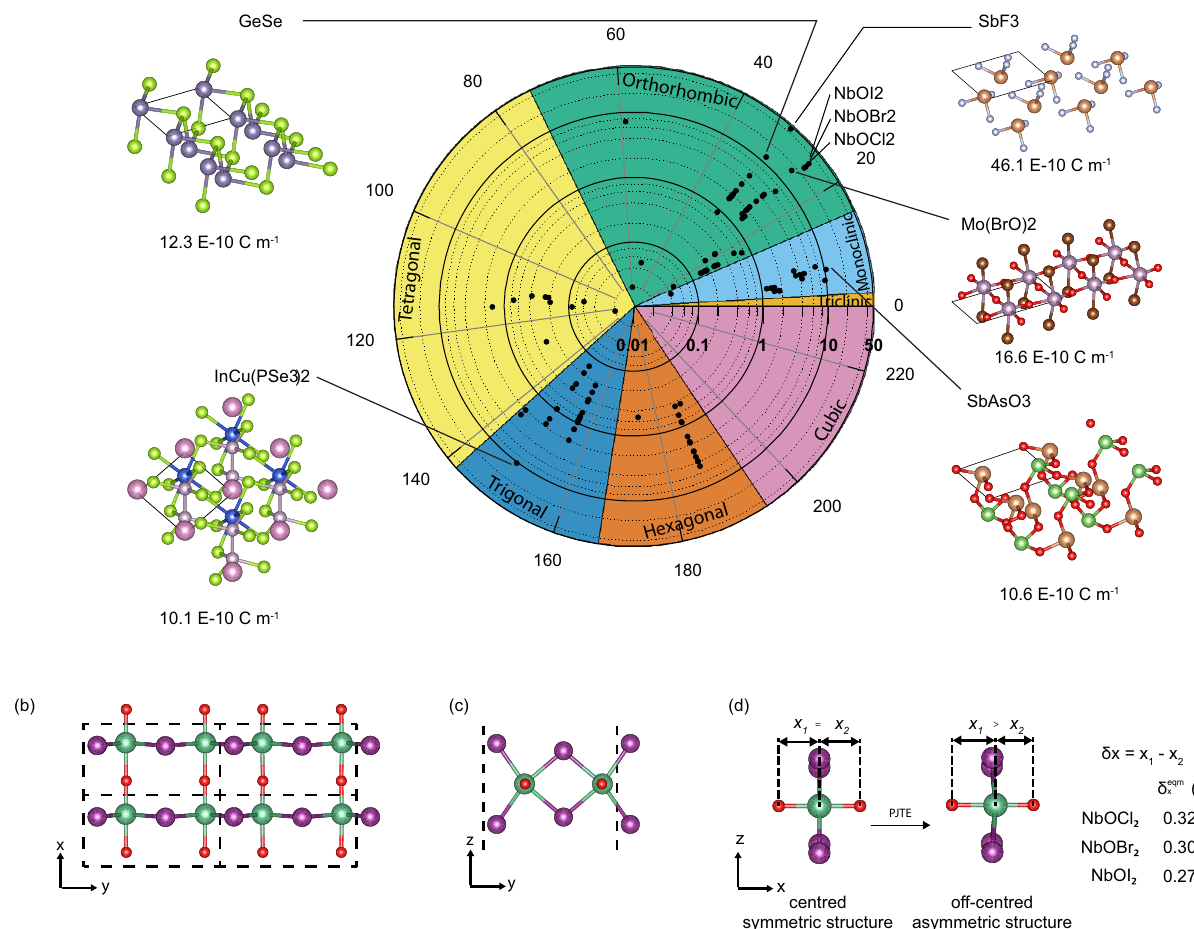
Fig. 2 Maximum sheet piezoelectric tensor elements and atomic structures of selected materials. a High-throughput calculation results for maximum sheet piezoelectric stress tensor elements ( e ij ). The radial axis represents the magnitude of e ij in units of 10 − 10 C m − 1 on a log scale and the angular axis represents the 230 space groups. Materials with e ij larger than 10 × 10 − 10 C m − 1 are labeled and their atomic structures are presented. The maximum e ij corresponds to e 26 for SbF 3 and to e 11 for NbOX 2 . Atomic structures of selected materials are also presented. b Top view and c Side view down the x -axis to the atomic structure of monolayer NbOX 2 (X = I, Br, Cl). Dark green balls denote Nb atoms; purple balls denote halogens; red balls denote O atoms. Dashed lines mark the unit cell boundaries. d Schematic, viewed along y -axis, showing relative displacement of Nb atoms along the x -axis away from the high symmetry position where δ x ¼ 0 Å, to the equilibrium position where δ x ¼ δ eqm x . Additional structural parameters are provided in Supplementary Table S3. PJTE refers to the pseudo-Jahn-Teller